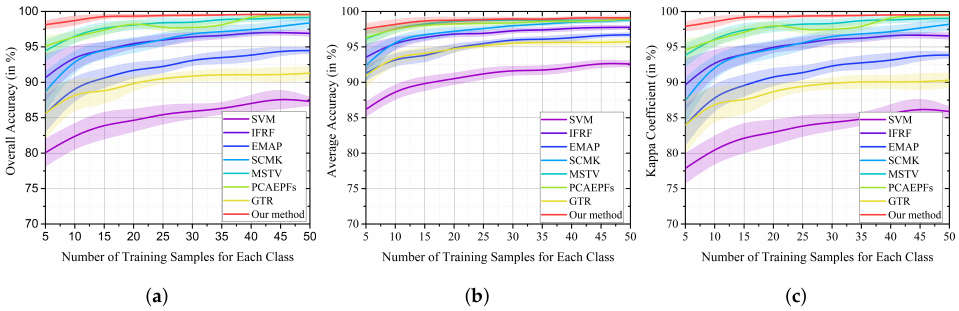
Figure 8. Classification performance of different approaches on the Salinas with different numbers of training samples. ( a ) OA. ( b ) AA. ( c ) Kappa. The widths of the line areas are the standard deviation of accuracies produced in ten experiments. Table 3. Classification performance of all methods on Salinas dataset. The bold denotes the best classification